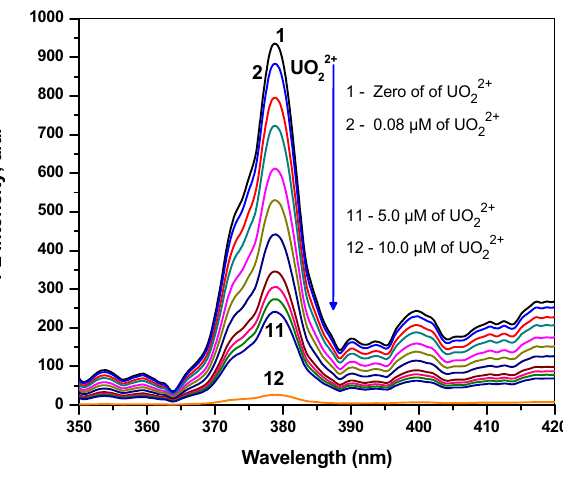
Figure 2: Fluorescence emission spectra of the L sensor in the pre - sence of di ff erent concentrations of UO 2 2 + at λ ex / λ em = 340/380